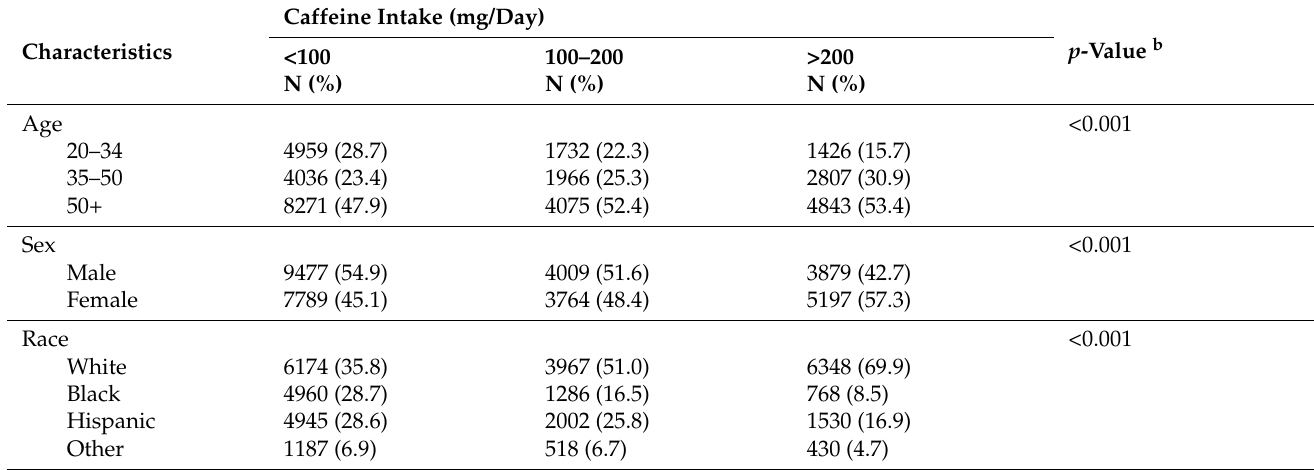
Table 1. Baseline Characteristics of Participants Stratified by Daily Caffeine Intake a